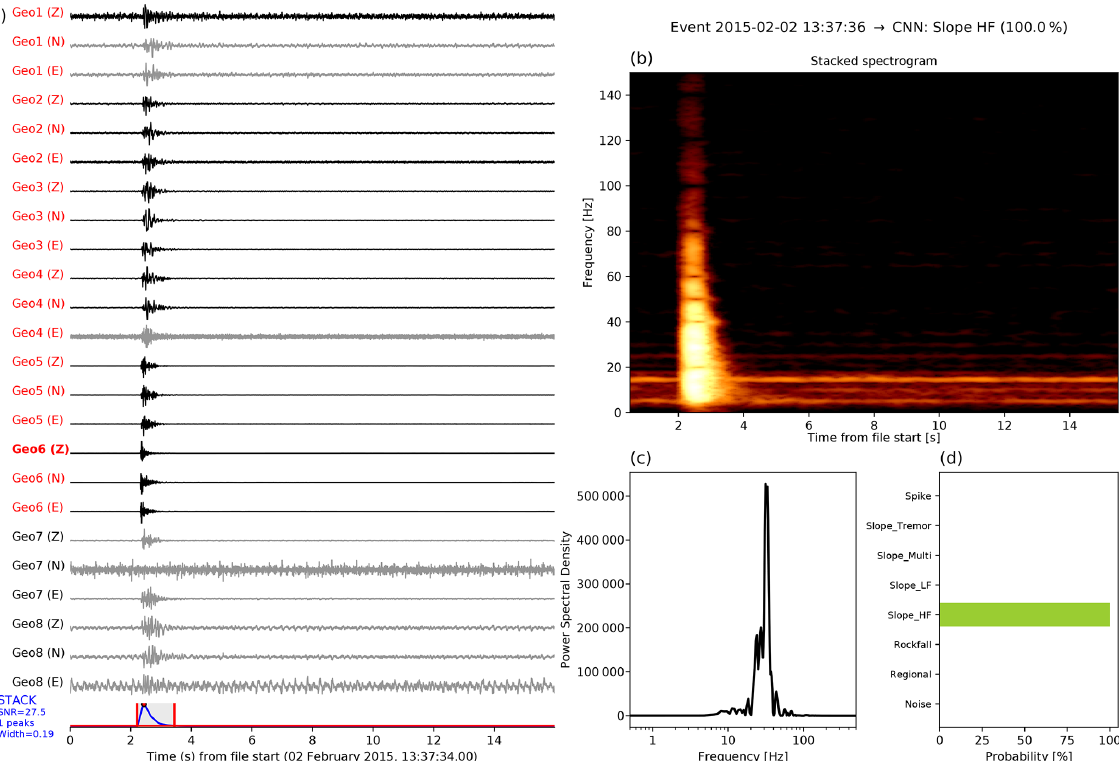
Figure 4. Example of an event classified as a high-frequency (HF) slope quake by the automatic classifier. In (a) , waveforms are shown for each component. Grey colour indicates geophones not contributing to the stack. Bold red text highlights the trace with maximum amplitude. The bottom trace represents the envelope stack of the traces with detection (black traces only). In (b) , the spectrogram resulting from the stack of individual spectrograms computed for each channel is plotted employing the colour scale used in the CNN. In (c) , the power spectral density (PSD) of the trace featuring the maximum amplitude is illustrated. Finally, in (d) , the bar displays the classification